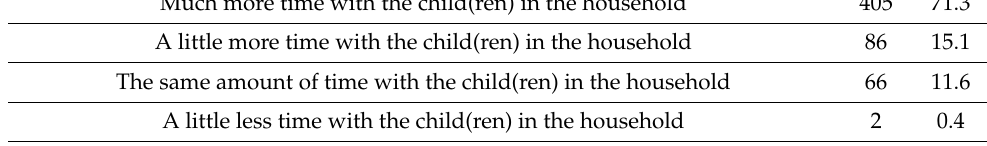
Table 1. The relative amount of time that the dog was reported to spend with household adults and children, during the last 7 days compared with early/mid-February 2020. Variable n % How much time does (dog name) currently spend with adults in the house, compared with early/mid-February (e.g., because of working longer shifts as a key worker, increased working from home, furlough or redundancy)? Currently much more 1965 49.3 Currently a little more 819 20.5 About the same 1160 29.1 Currently a little less 25 0.6 Currently much less 17 0.4 Compared to an average term-time week during early/mid-February 2020, (dog name) has spent... Much more time with the child(ren) in the household 405 71.3 A little more time with the child(ren) in the household 86 15.1 The same amount of time with the child(ren) in the household 66 11.6